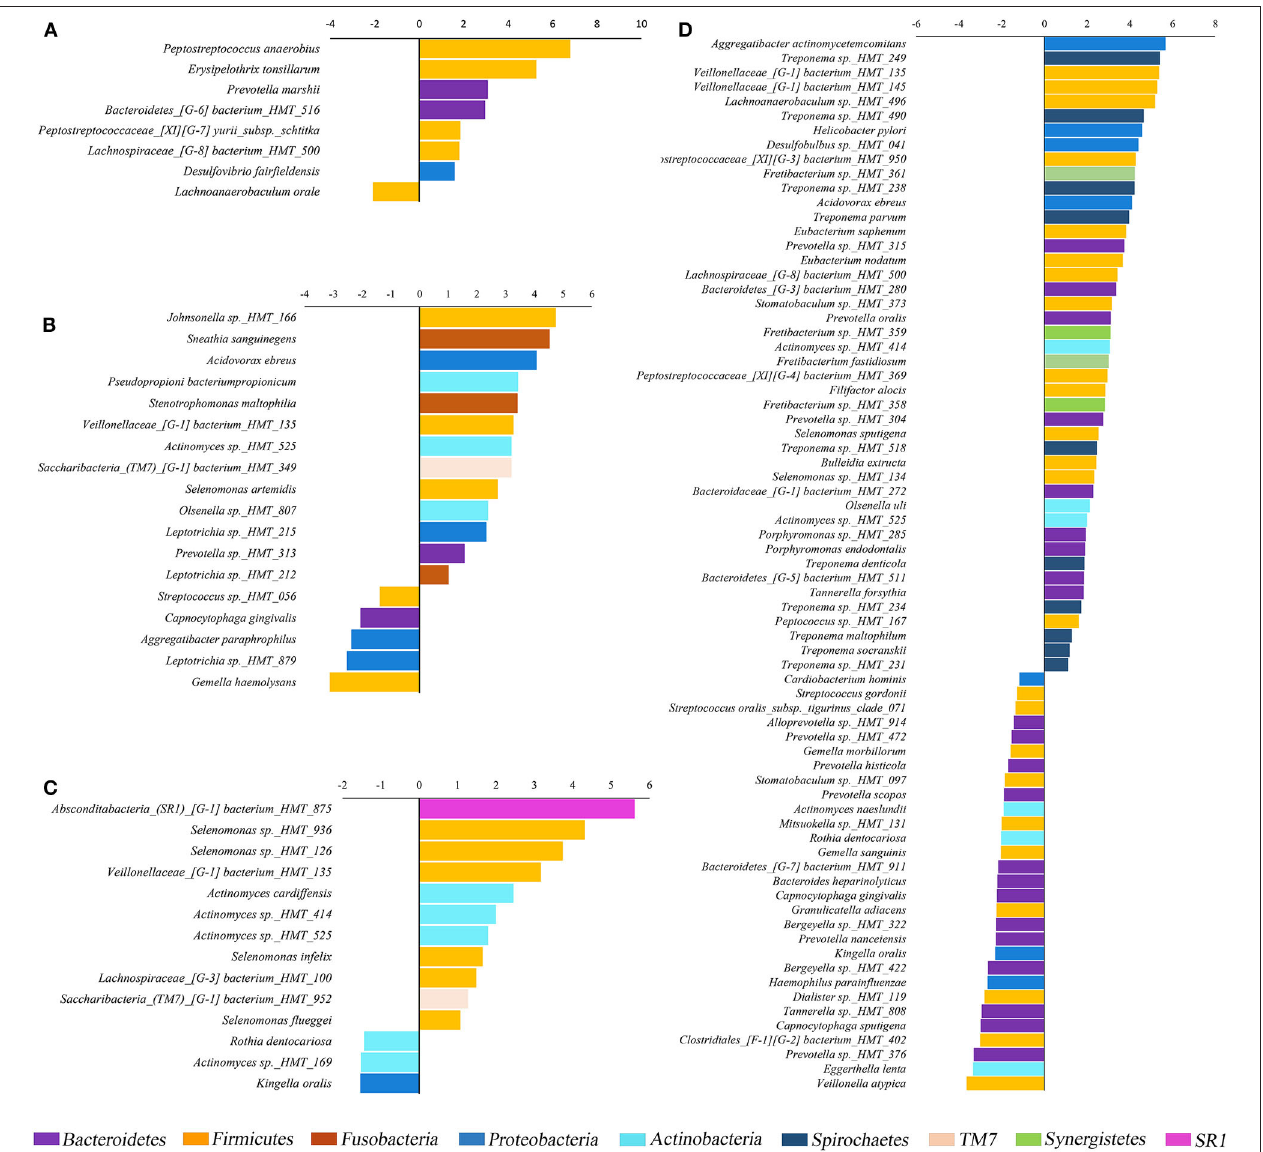
FIGURE 2 | Fold changes (log 2 ) of species relative abundance. Species detected in lower (negative values) or higher abundance (positive values) in GC/MIP samples compared to Control in: fecal samples (A) , supragingival sites (B) , subgingival healthy sites (C) , and subgingival affected sites of GC/MIP compared to subgingival healthy sites of Control (D) . Only species that significantly differed between groups were displayed ( p < 0.05, Non-parametric t